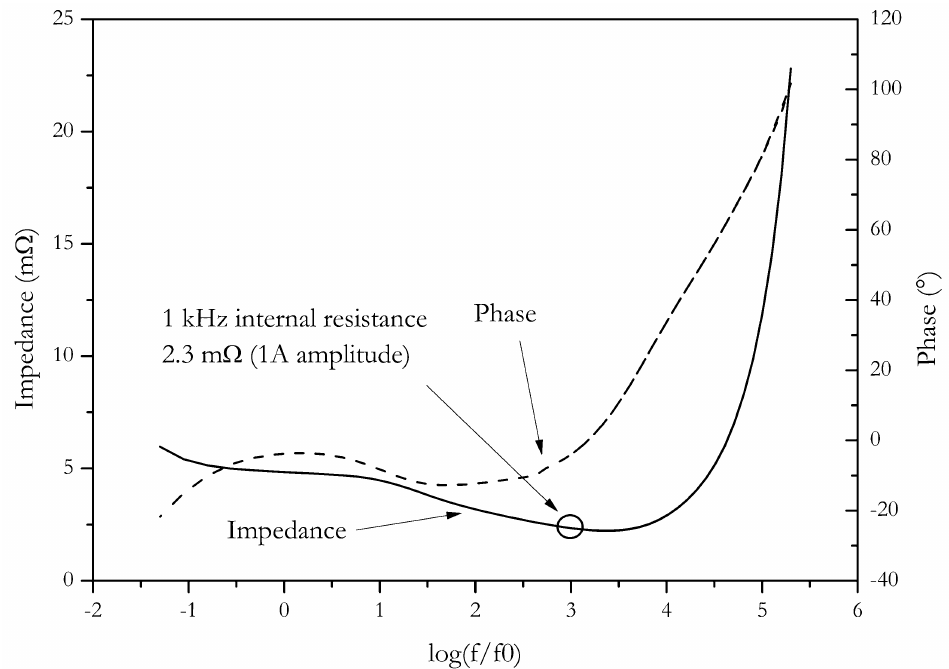
Figure 10. Bode plot of the NX2P0M cell, f0 = 1